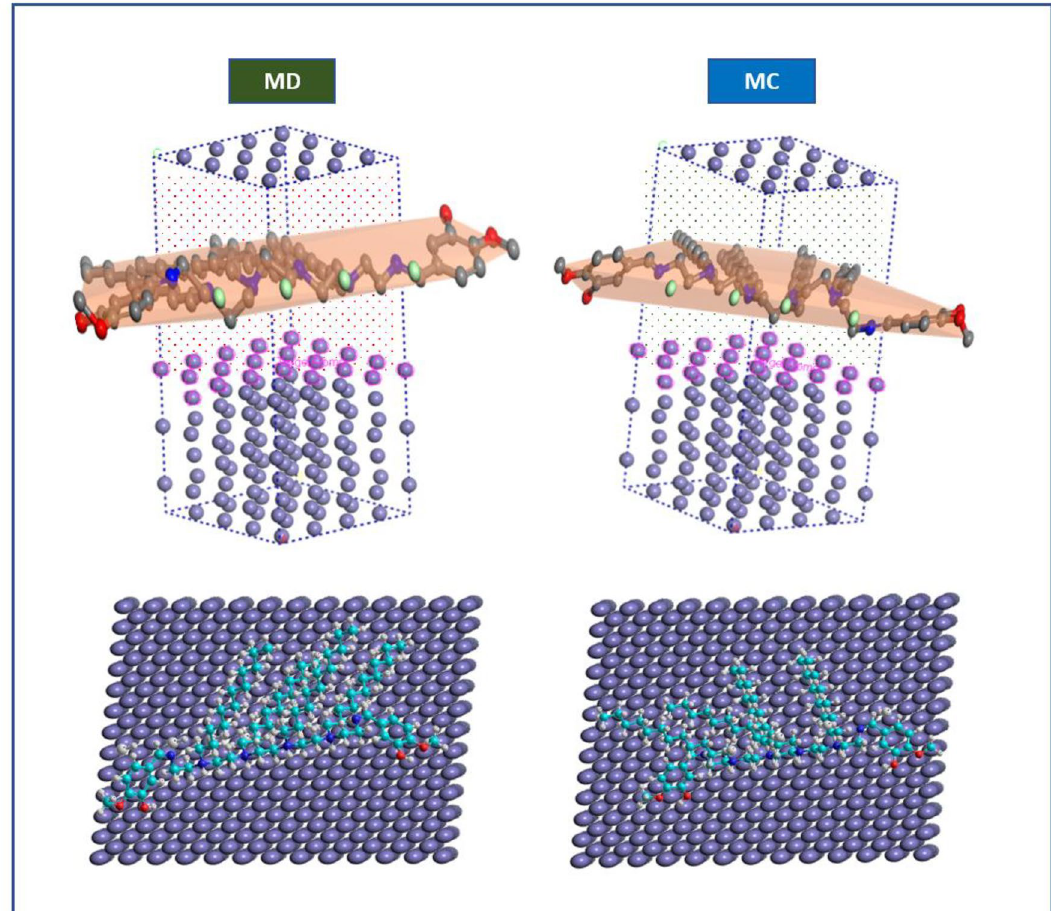
Figure 11. MD and MC obtained from the adsorption configurations of CS4 on Fe (110)